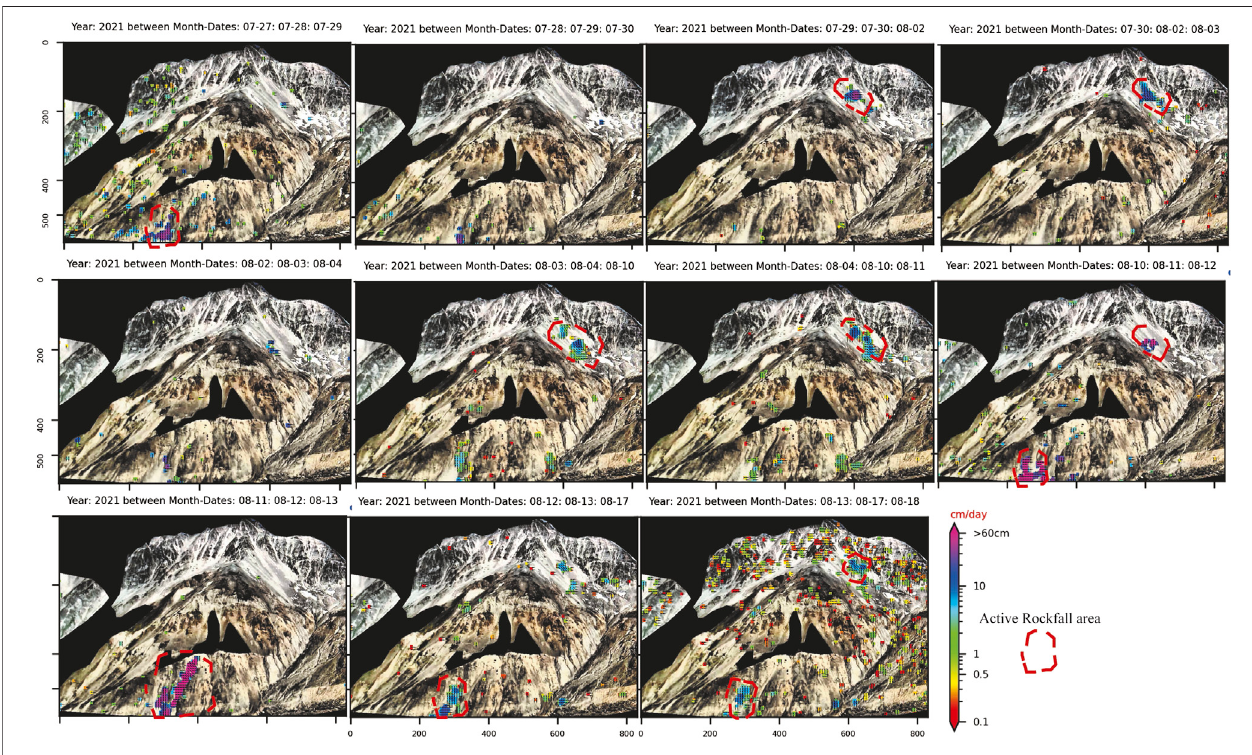
FIGURE 8 | Example of dynamic change detection at 2 p.m. daily for the Plinth Peak slope. Refer to the GitHub repository for temporal dynamic change detection results at 11 a.m., 12 p.m., and 1 p.m.